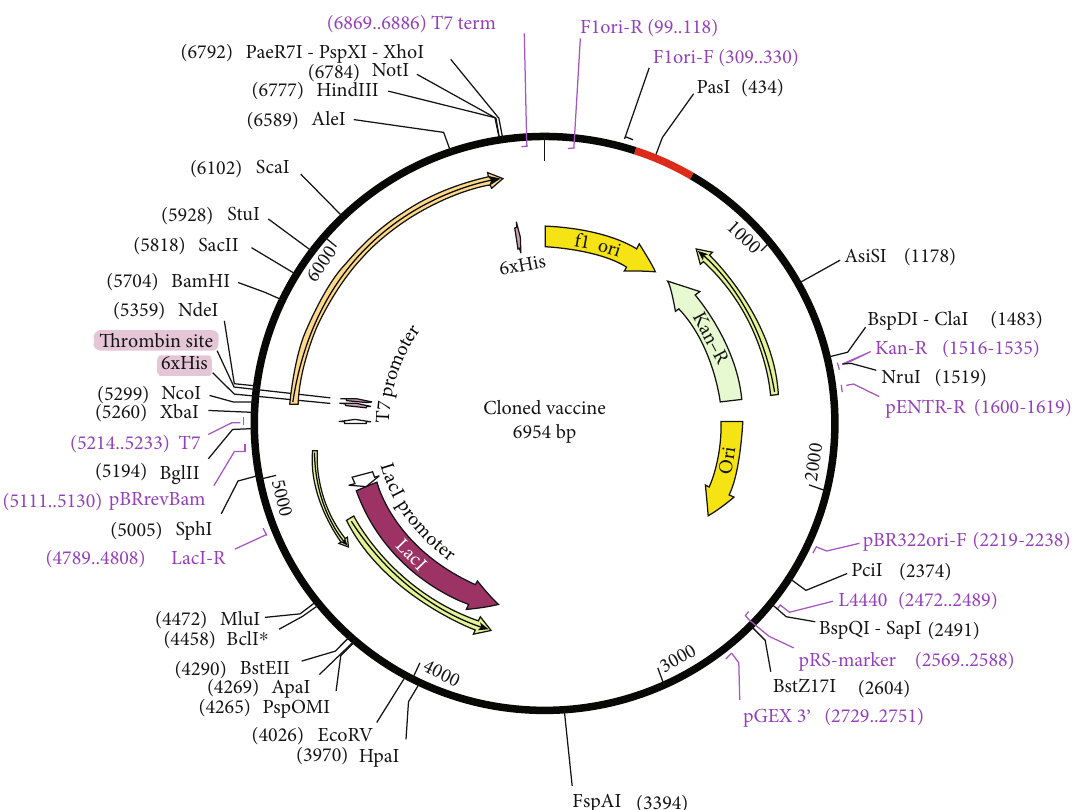
Figure 10: In silico cloning of the fi nal vaccine construct into an expression vector where the red part indicates the coding gene for the vaccine enzymatically restricted by